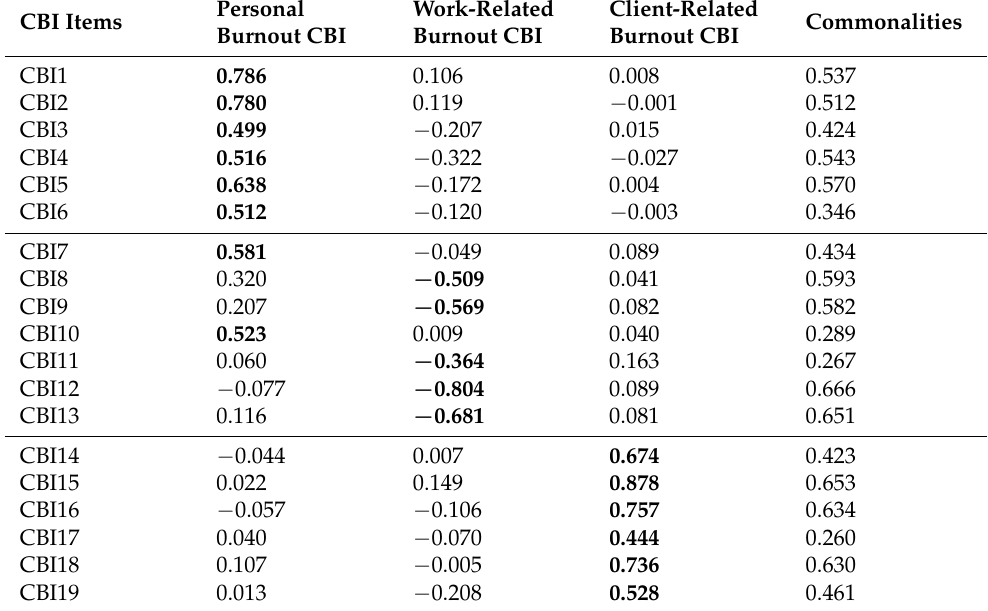
Table 5. Factor loadings of the CBI